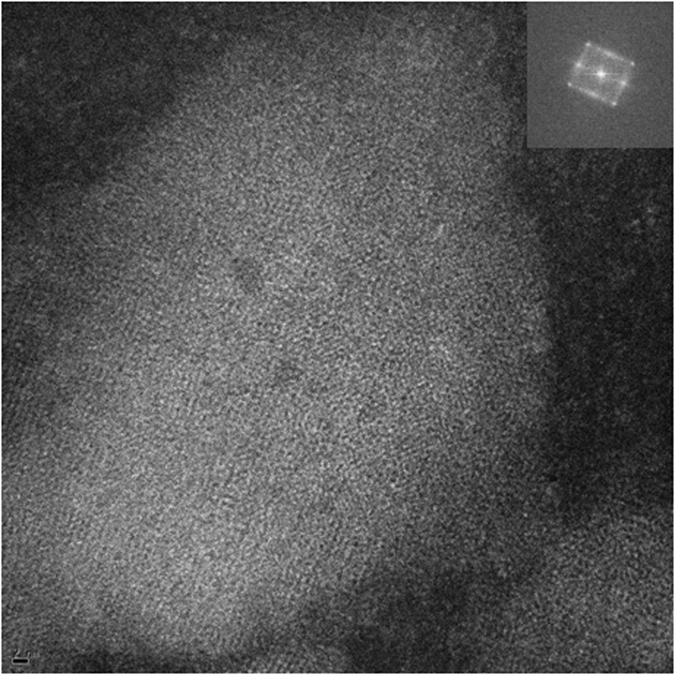
ADF-STEM image showing the co-crystal of Lu3N@C80-PCBEH:DIO with the corresponding FFT(inset).